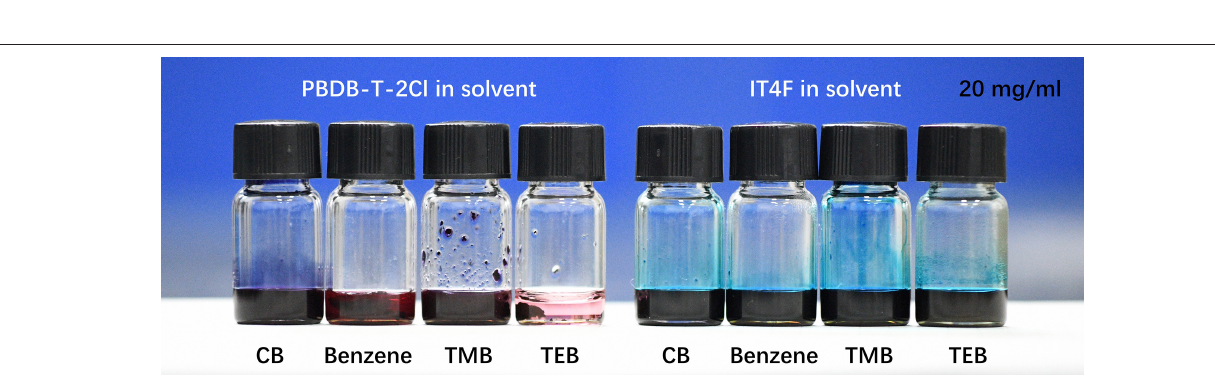
FIGURE 5 | The solubility of IT4F and PBDB-T-2Cl in CB, benzene, TMB, and TEB. IT4F could easily be dissolved in benzene, TMB, and TEB, while PBDB-T-2Cl has a very low solubility in benzene, TMB, and TEB.